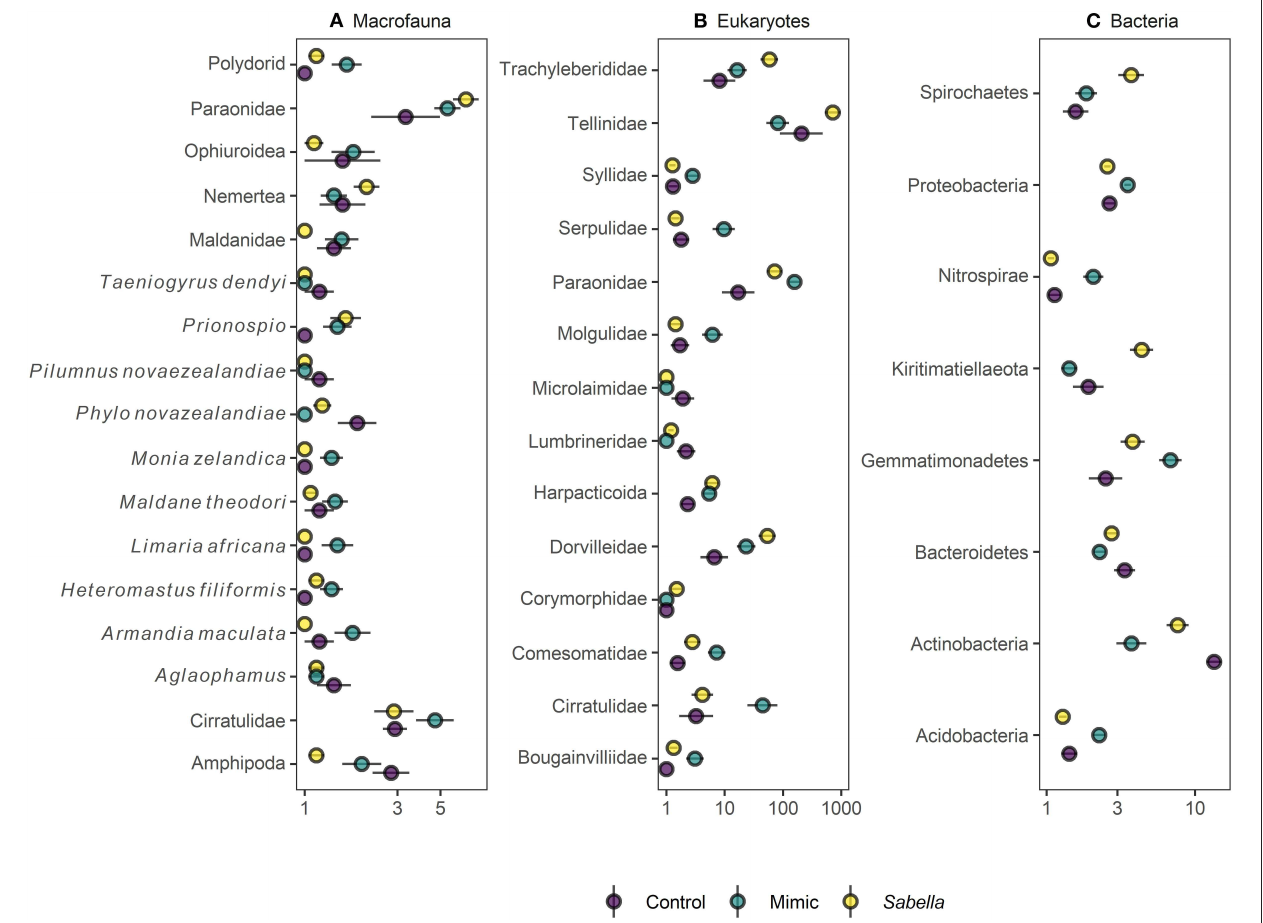
FIGURE 4 | Mean ( ± SE) relative abundance (%) of indicator taxa for (A) macrofaunal, (B) eukaryote, and (C) bacterial communities in “Control” (purple circles), “Mimic” (green circles) and “ Sabella ” (yellow circles) experimental plots.